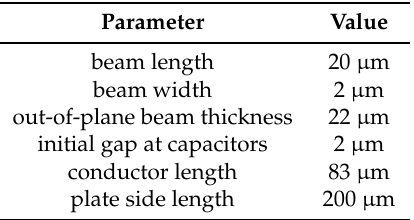
Table 1. Target geometric dimensions of the device (see Figure 1).